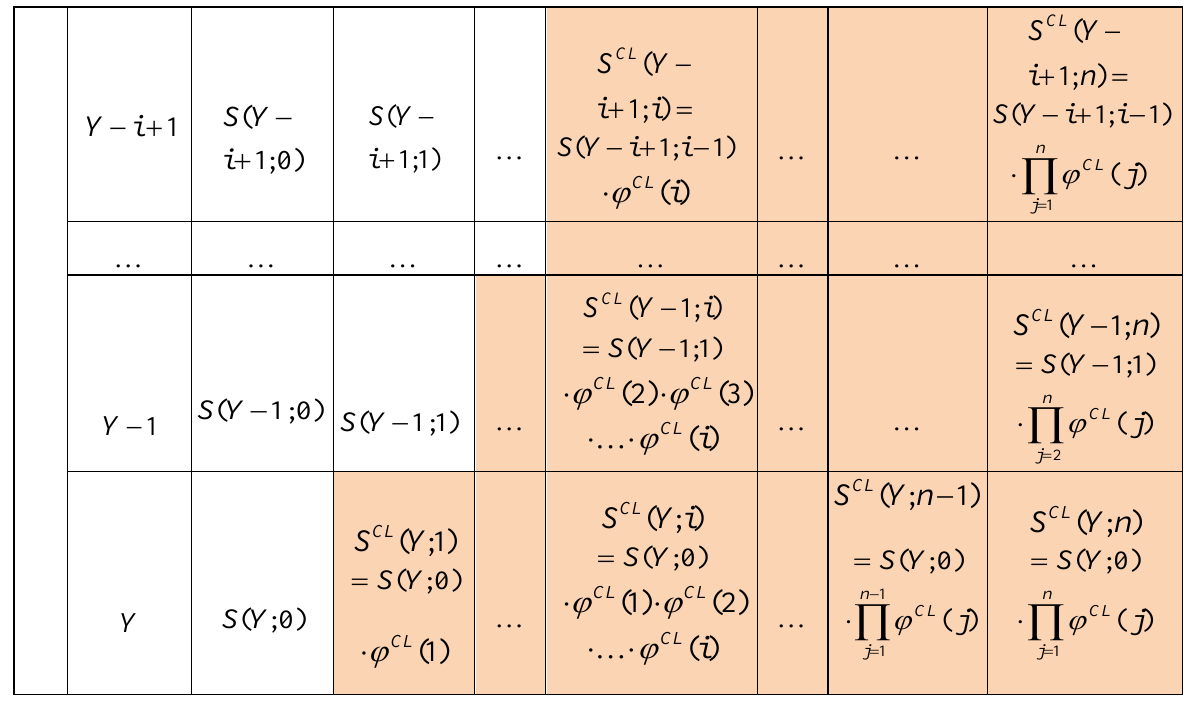
Fig. 4. Determining the CLM estimators for the future cumulative claims loss settlement